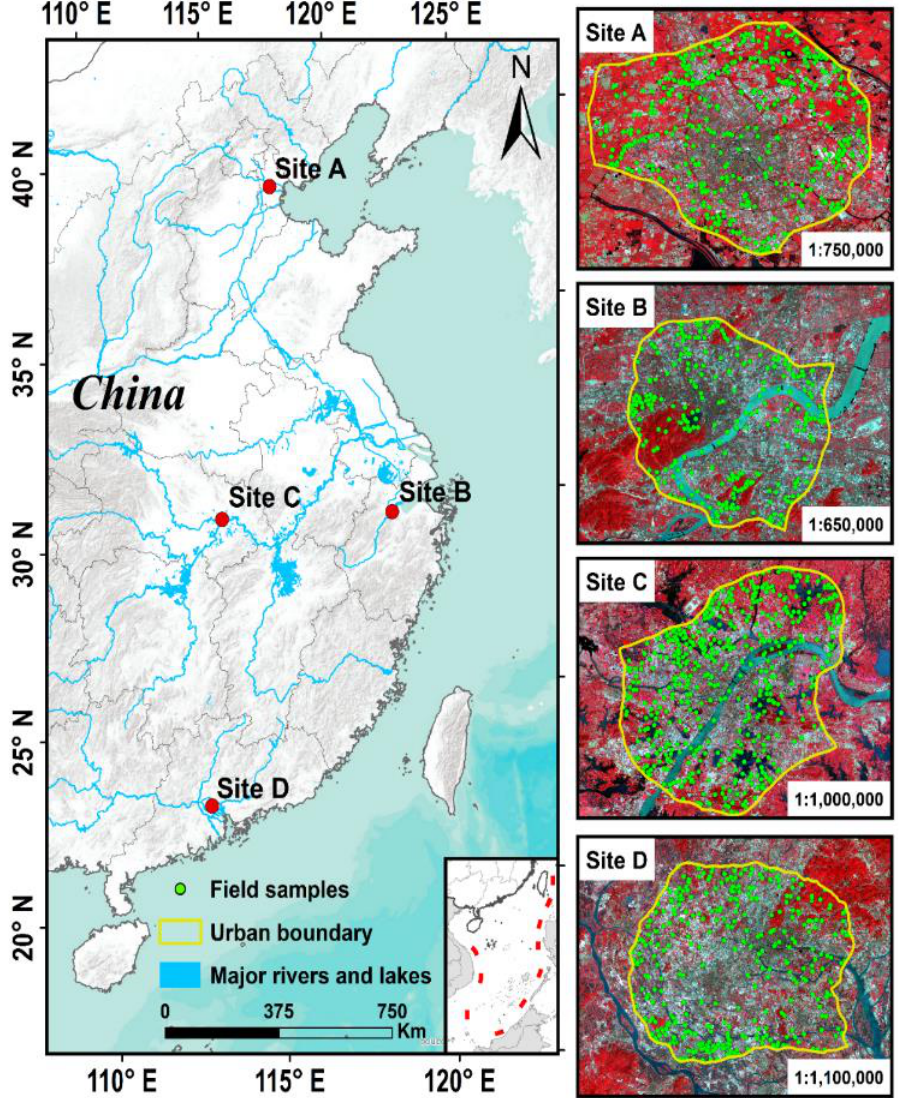
Figure 1. Geographic locations of the four study sites and distributions of field samples in each site. Site ( A – D ) represent urban area of Tianjin, Hangzhou, Wuhan, and Guangzhou, respectively. The backgrounds in the views are the Landsat 8 OLI images (bands 5, 4, 3 as RGB).